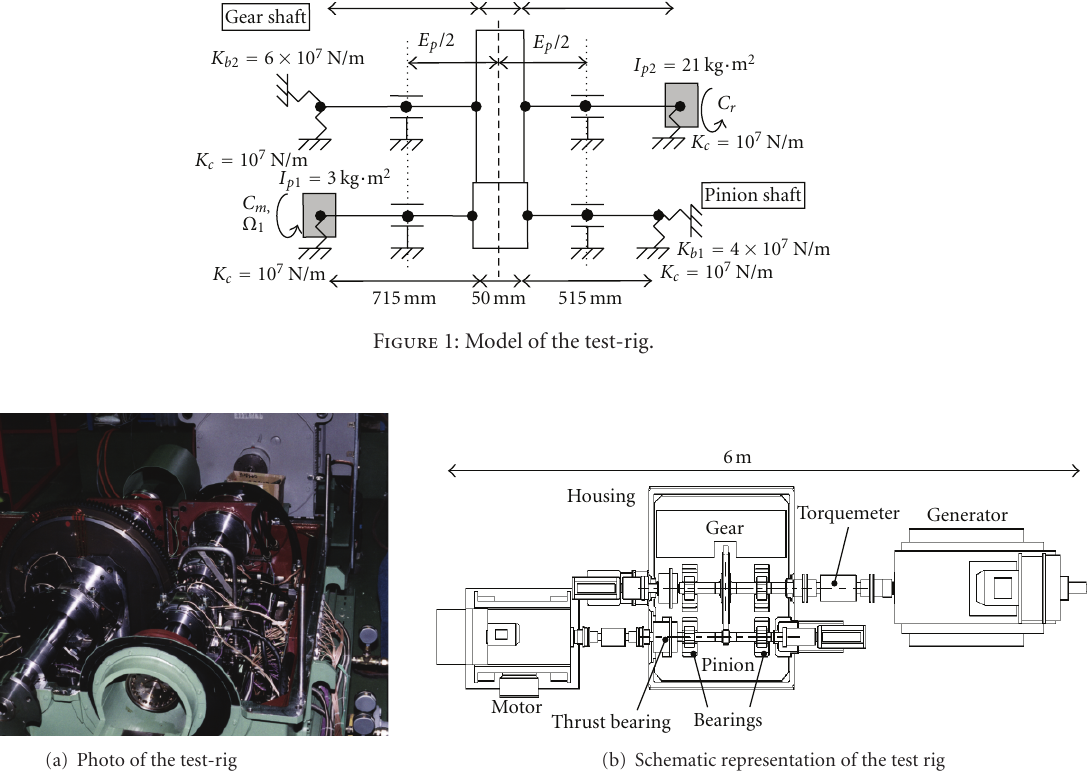
Figure 2: Presentation of the test